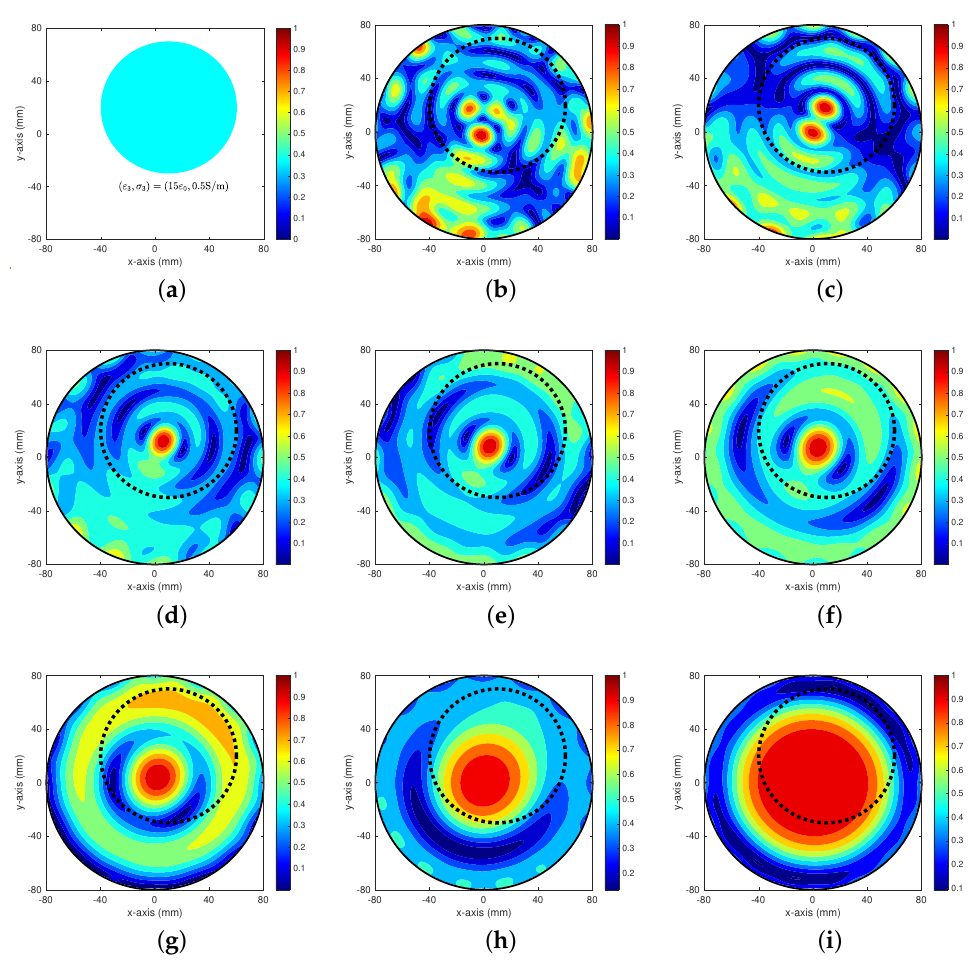
Figure 5. (Example 3) Maps of F BS ( r , n ) . Black-colored dashed line describes the boundary of objective. ( a ) Large objective, ( b ) n = 1, ( c ) n = 2, ( d ) n = 3, ( e ) n = 4, ( f ) n = 5, ( g ) n = 6, ( h ) n = 7, ( i ) n = 8.